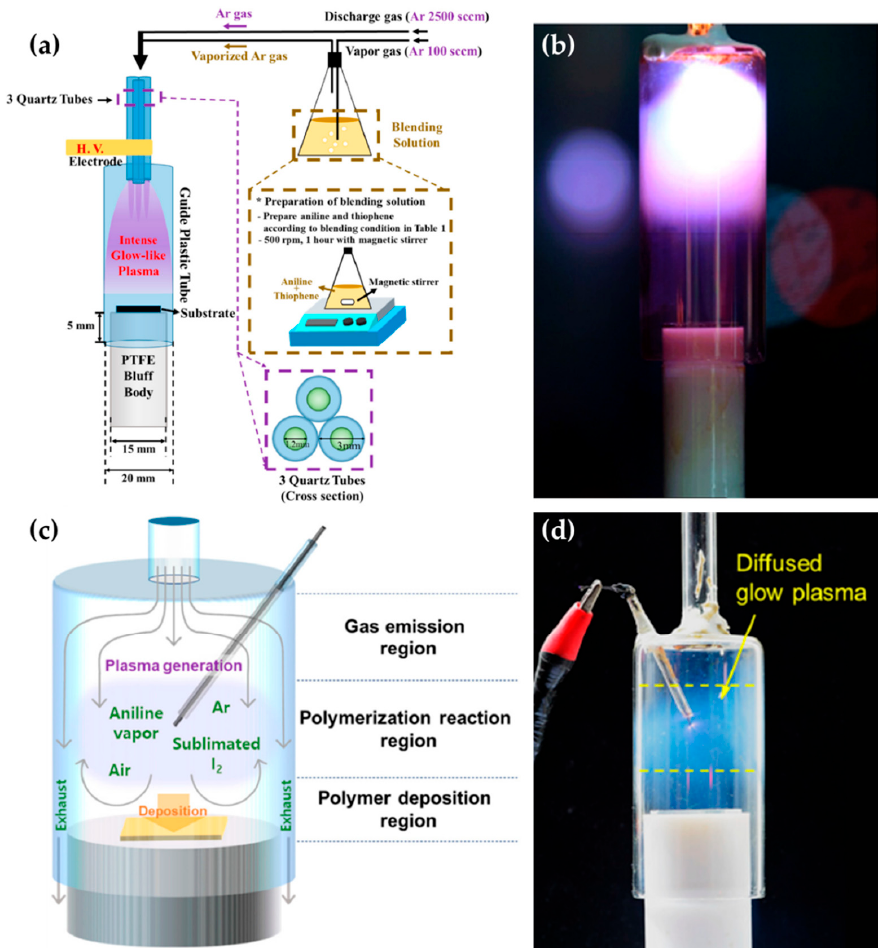
Figure 4. ( a ) Setup [59] and ( b ) photo image [62] of the APPJ with three array jets and a GB system. ( c ) Configuration [63] and ( d ) photo image [64] of the pin-type APPJ with a GB system.